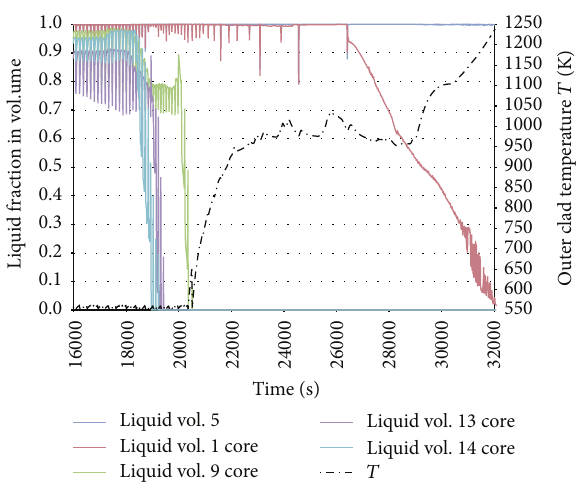
Figure 10: Void fraction in four axial nodes of fuel channel 2 and in its nose during the first hours of SBO. Clad temperature corresponds to the hottest axial node in this channel.